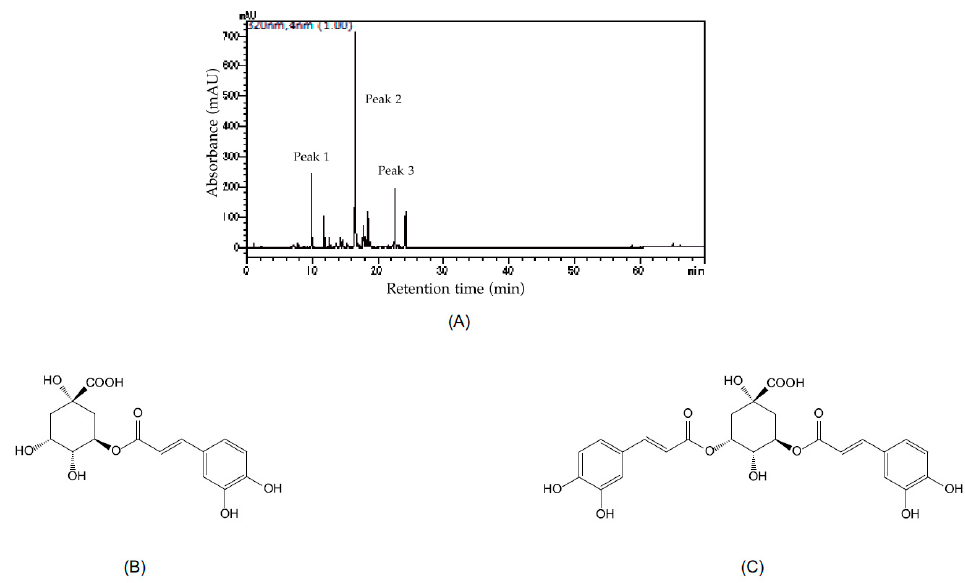
Figure 3. HPLC-DAD results of A. indica var. maximowiczii root extract. ( A ) HPLC chromatogram at 320 nm of root extracts of A. indica var. maximowiczii.; retention times of peaks 1, 2 and 3 are 9.86 min, 16.52 min and 22.83 min, respectively; ( B ) chemical structure of chlorogenic acid; ( C ) chemical structure of 3,5-dicaffeoylquinic